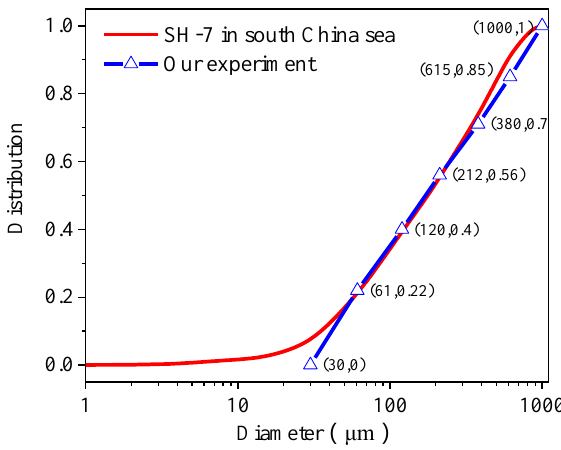
Figure 6. Grain size composition used to synthesize hydrate samples.